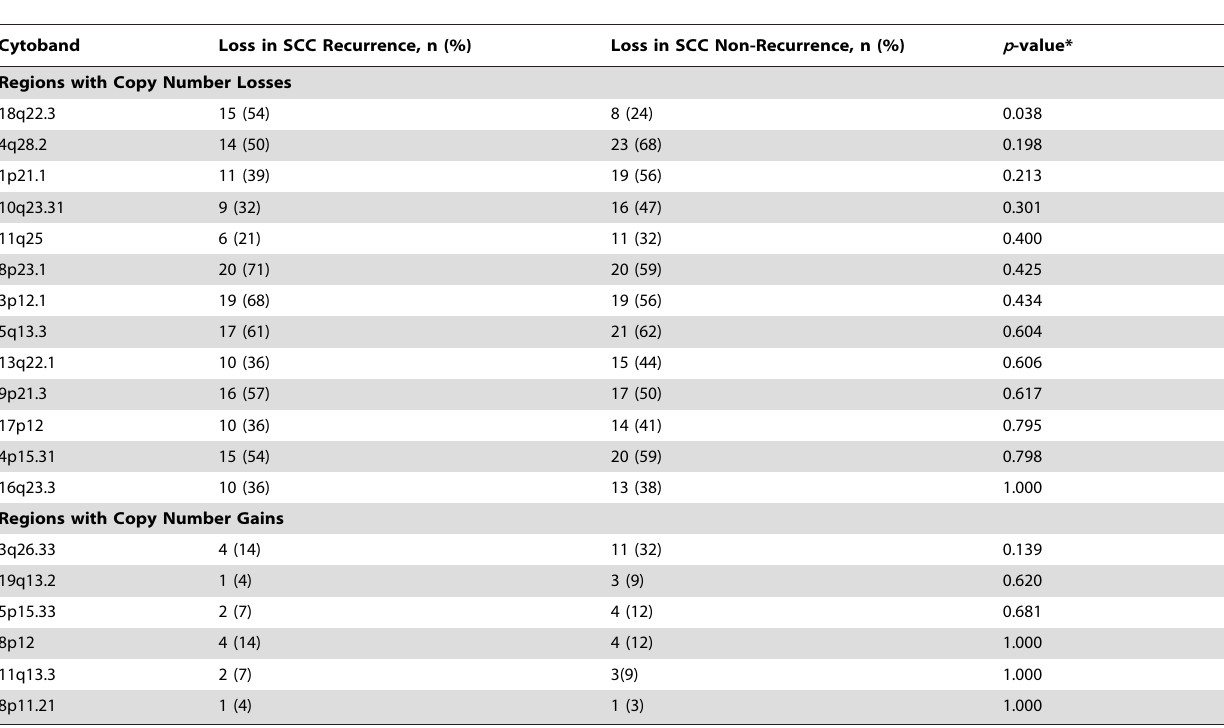
Table 3. Frequency of Copy Number Alterations of GISTIC Identified Chromosomal Regions in Recurrence and Non-recurrence SCC Training Set